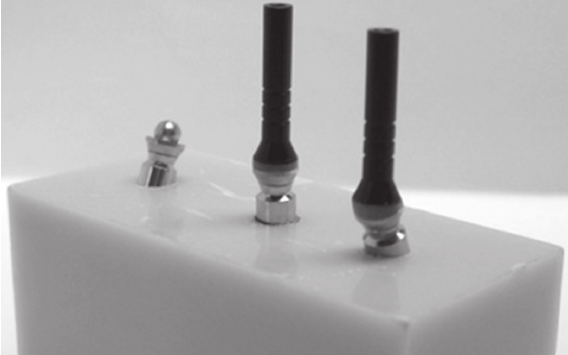
Figure 3- Special components of the I-Bridge ® 2 system, called the I-Flex™, placed on the implants prior to